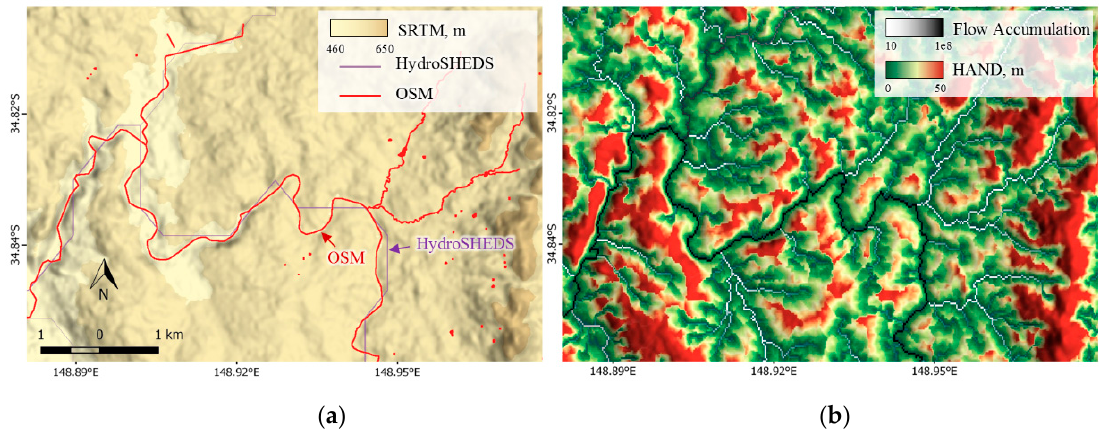
Figure 3. Digital elevation model, SRTM 30 m ( a ); and height above the nearest drainage ( b